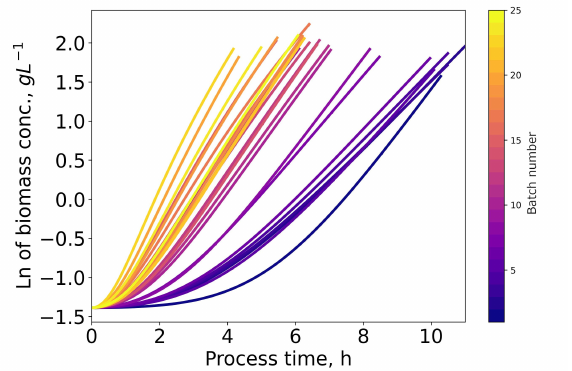
Figure 4. The logarithm of the biomass concentration is depicted over the process time. Each line represents a single batch of the same ALE experiment (GM2). The chronological order of the batches is indicated by the color bar. Early batches show an extended period with a non-linear relationship (lag), which decreases in length as the culture evolves towards a stable